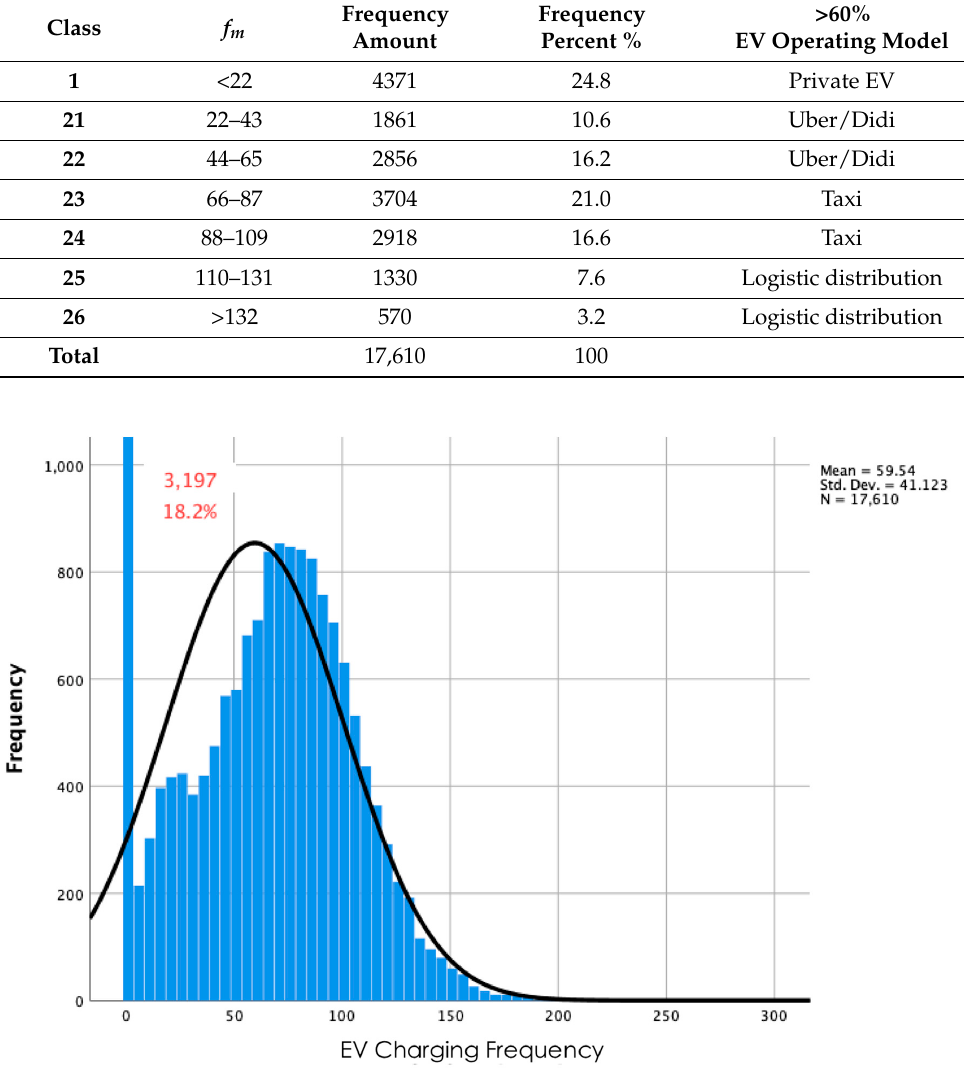
Figure 7. Comparison of the density function of log-normal distribution and the frequency density.